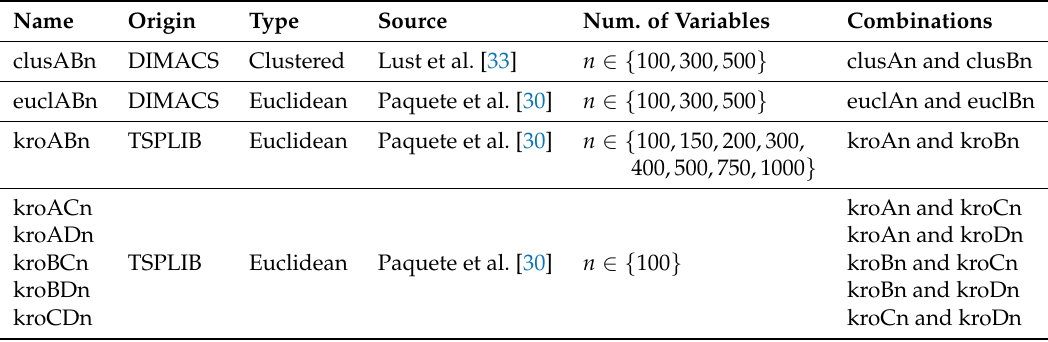
Table 2. Bi-objective TSP